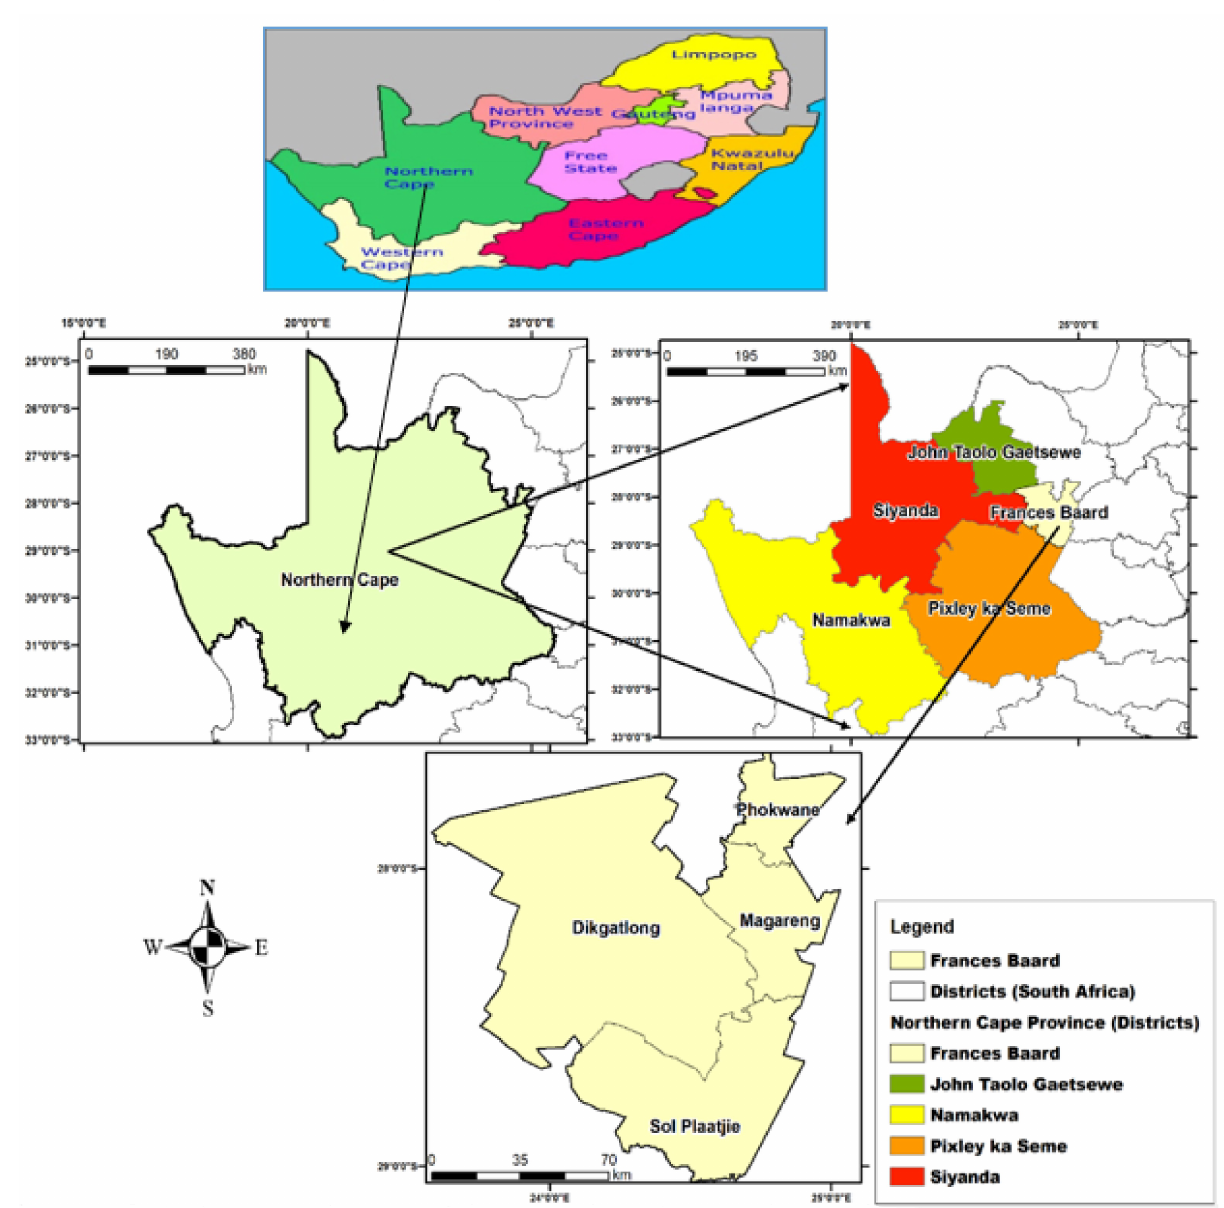
Figure 2. Maps of South Africa highlighting the Northern Cape Province, district municipalities of the Northern Cape, and the four local municipalities of FBDM. Source: FBDM [36].